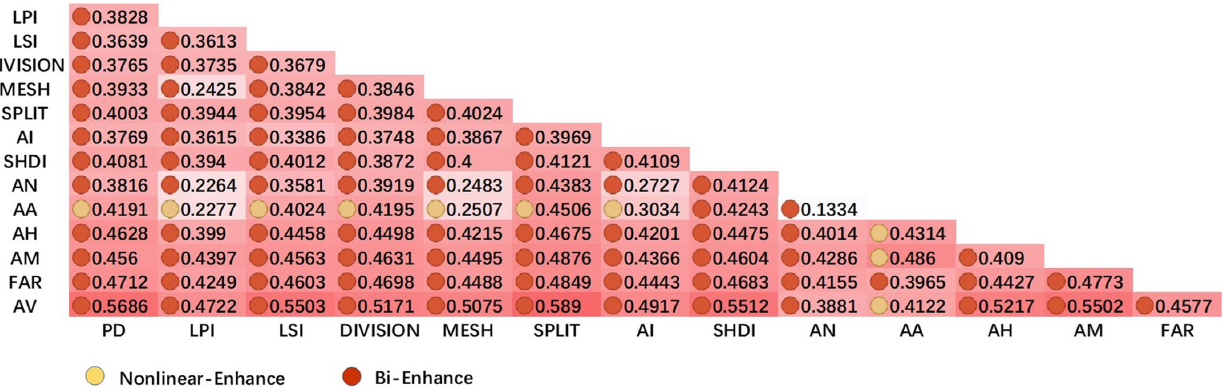
Figure 8. The interaction detector results of USS features on NTLI.